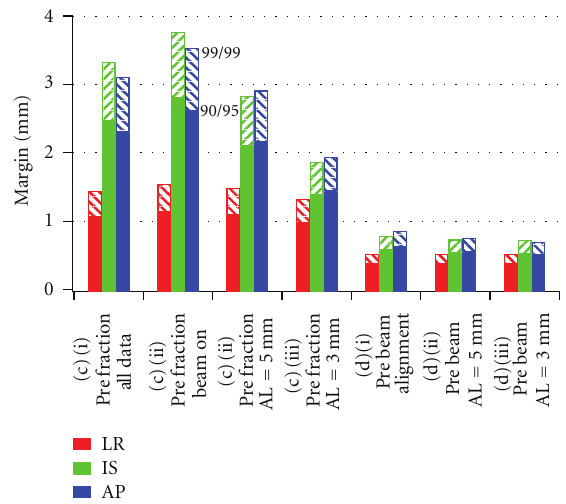
Figure 2: PTV margins for real-time correction strategies for which 90% or 99% of patients receive a minimum dose greater than 95% or 99% of the prescription dose, respectively. Margins based on (c) prefraction, (d) prebeam correction (i) alone, or with further correction at thresholds of (ii) 5mm and (iii) 3 mm are shown. Margins decrease with increased levels of corrective